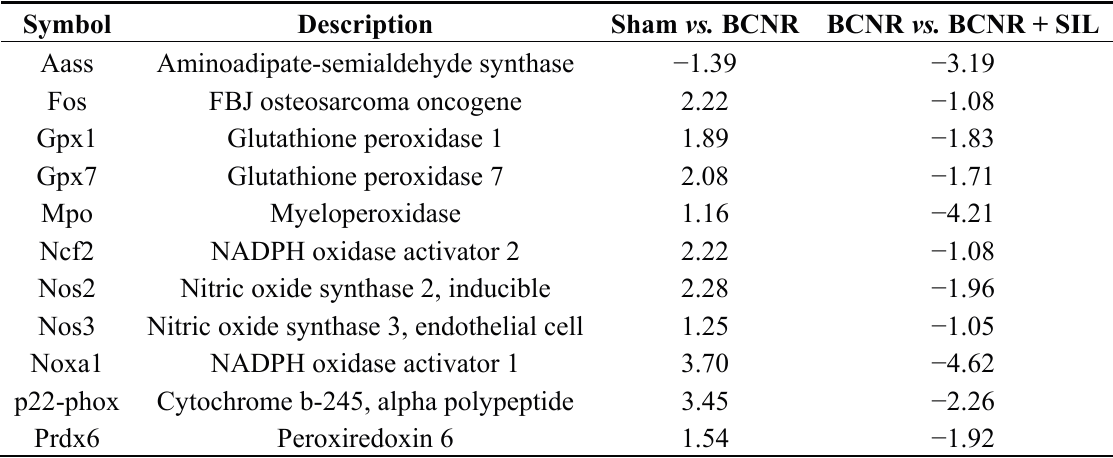
Table 2. Changes in the gene expression profile of nitric oxide and oxidative stress markers after BCNR and treatment with SIL determined by PCR array.